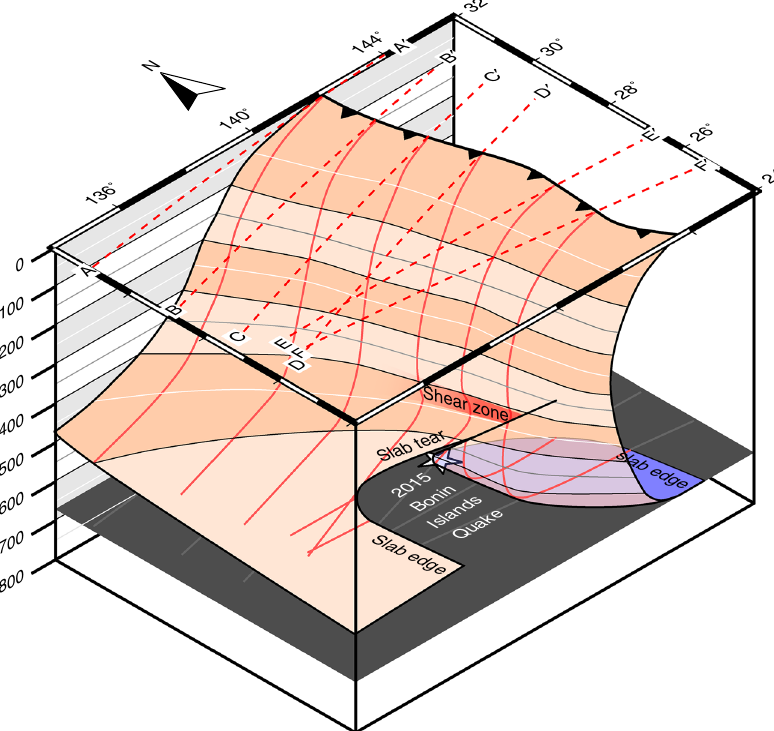
Fig. 3 Isometric cartoon of the surface of the present-day Izu – Bonin slab based on the tomographic images. The sections shown in Fig. 2 are projected onto the 0 km-depth isocontour (dotted red lines), and onto the surface of the slab (solid red lines). The blue region marks where the slab is overturned. The dark grey surface marks the “ 660 ” -km-depth isocontour. The location of the 2015 Bonin Islands earthquake is shown as a white star. Other labelled features correspond to those mentioned in the main